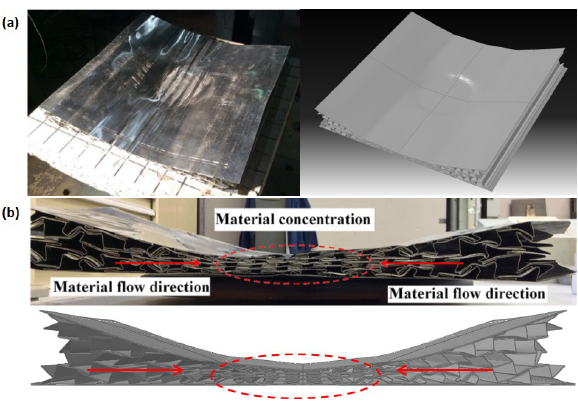
Figure 4: Comparison between experimental and numerical results